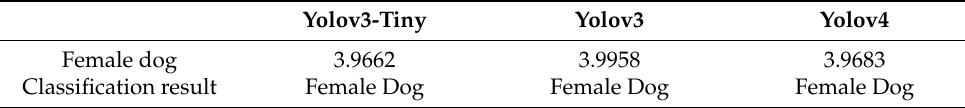
Table 8. Classification results of female dog images by the majority voting algorithm.